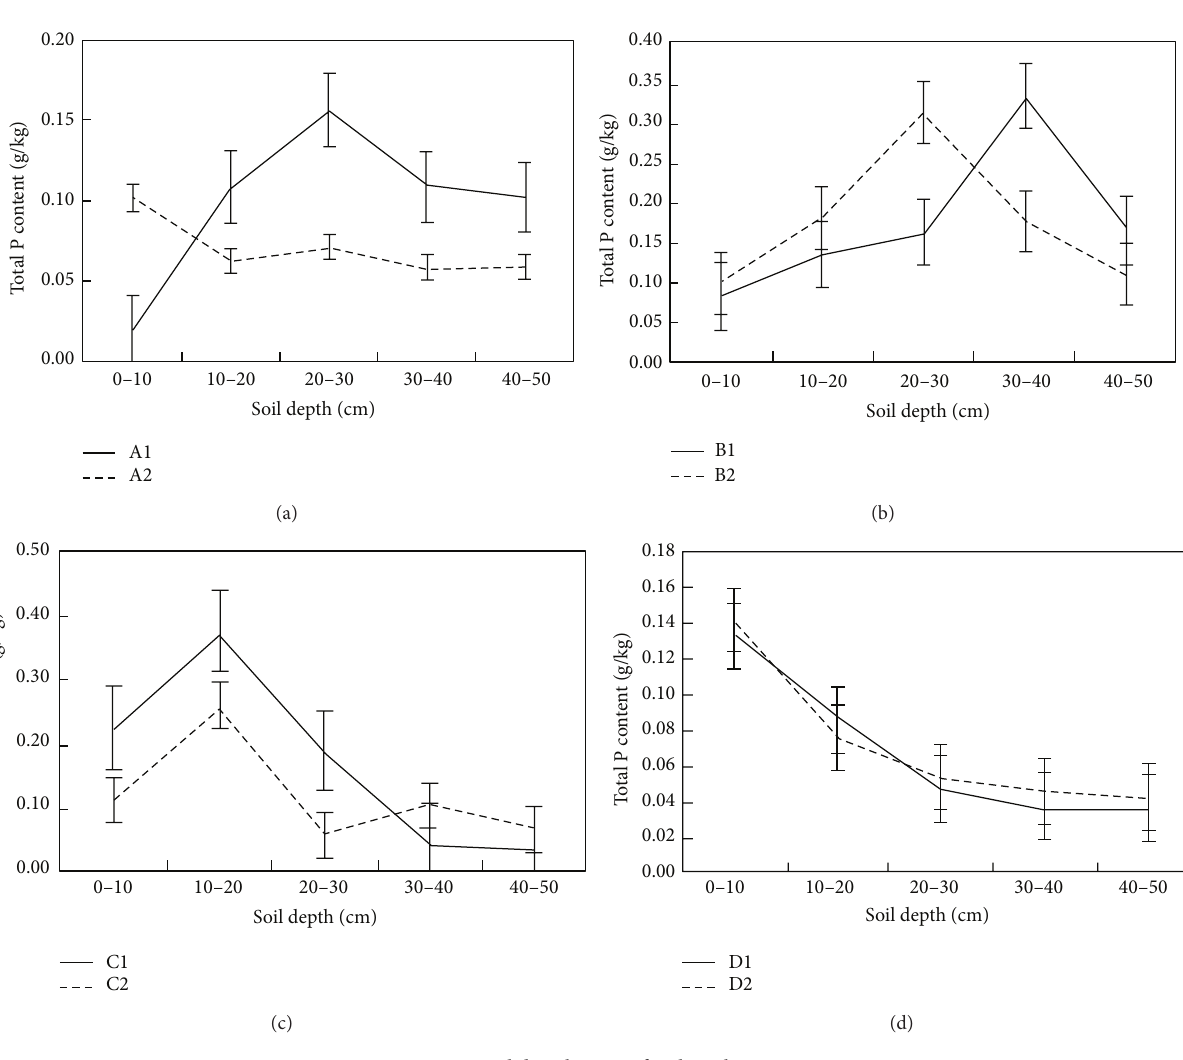
Figure 6: Spatial distribution of soil total P